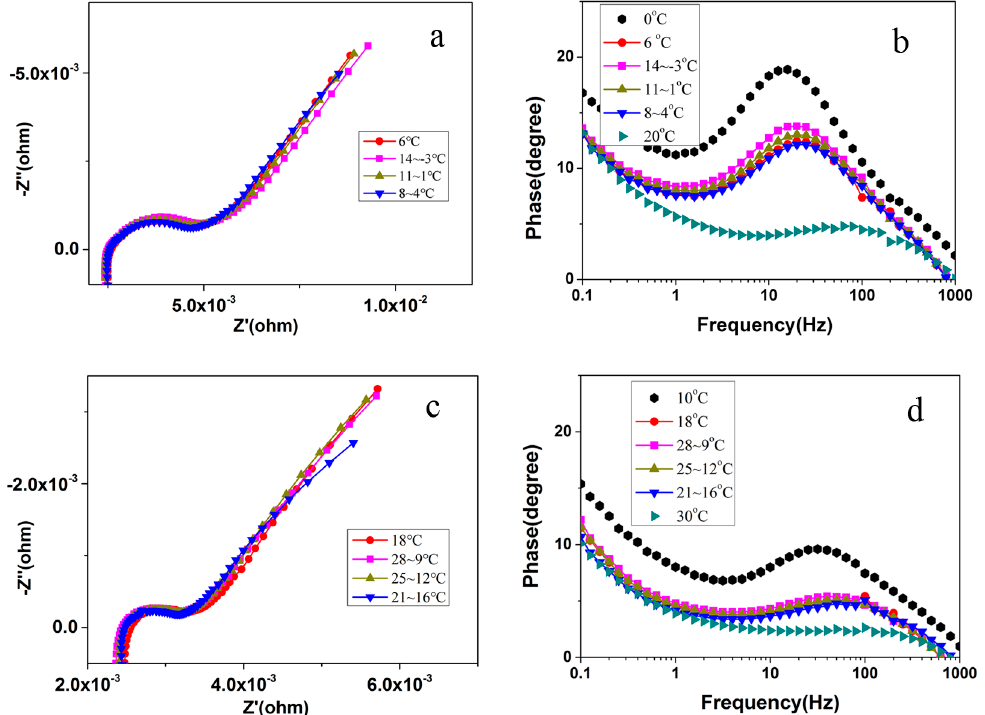
Figure 5. EIS and phase shift with artificial temperature gradients: ( a , c ) EIS results; and ( b , d ) phase shift results.